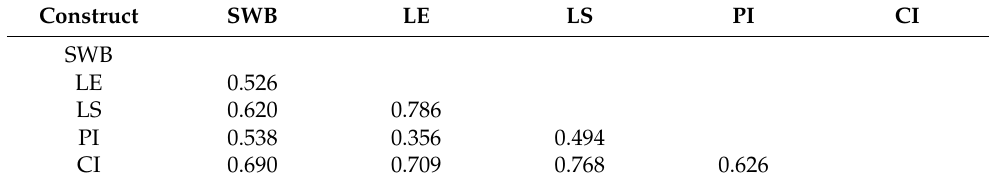
Table 5. The discriminant validity of the constructs, according to the Heterotrait–Monotrait